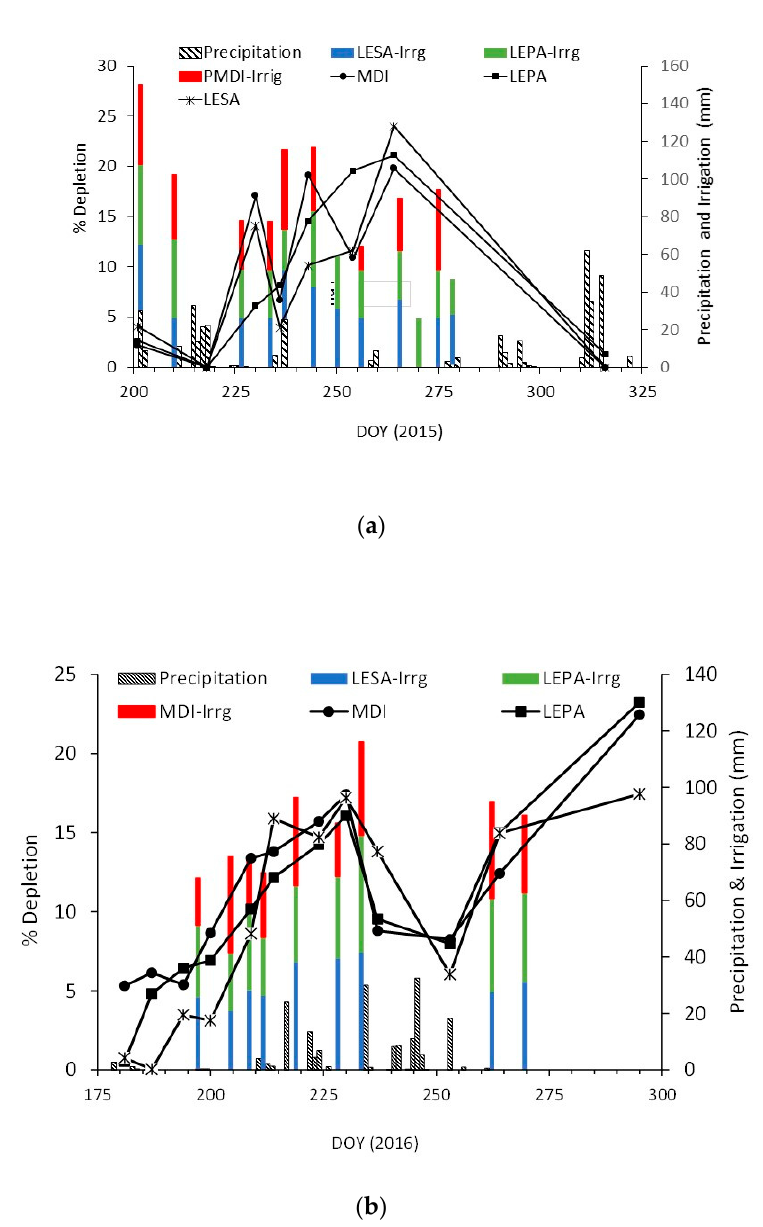
Figure 1. Average percent soil water depletion in the top 1.5 m depth (calculated using Equation 2) of treatment plots for mobile drip irrigation (MDI), low energy precision application (LEPA) and low elevation spray application (LESA) methods during: ( a ) the 2015 and ( b ) 2016 growing seasons.